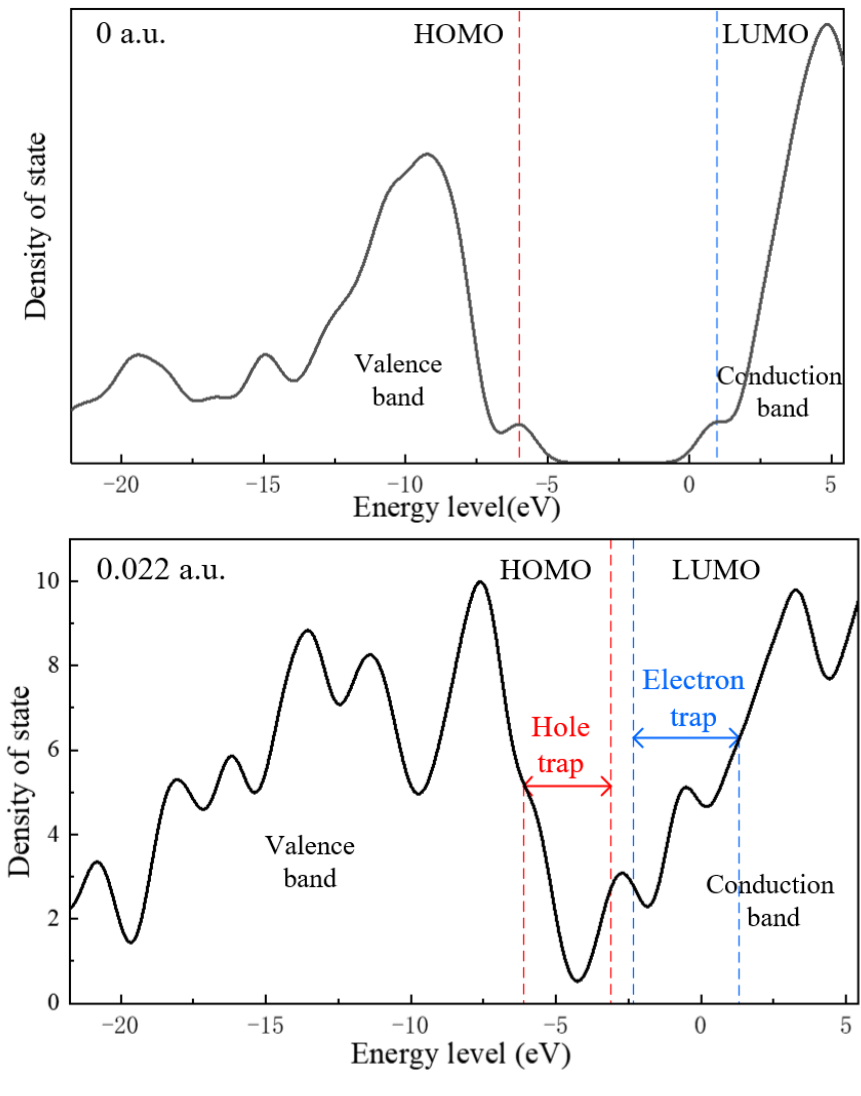
Figure 8. The density of states at 0 a.u. and 0.022 a.u.